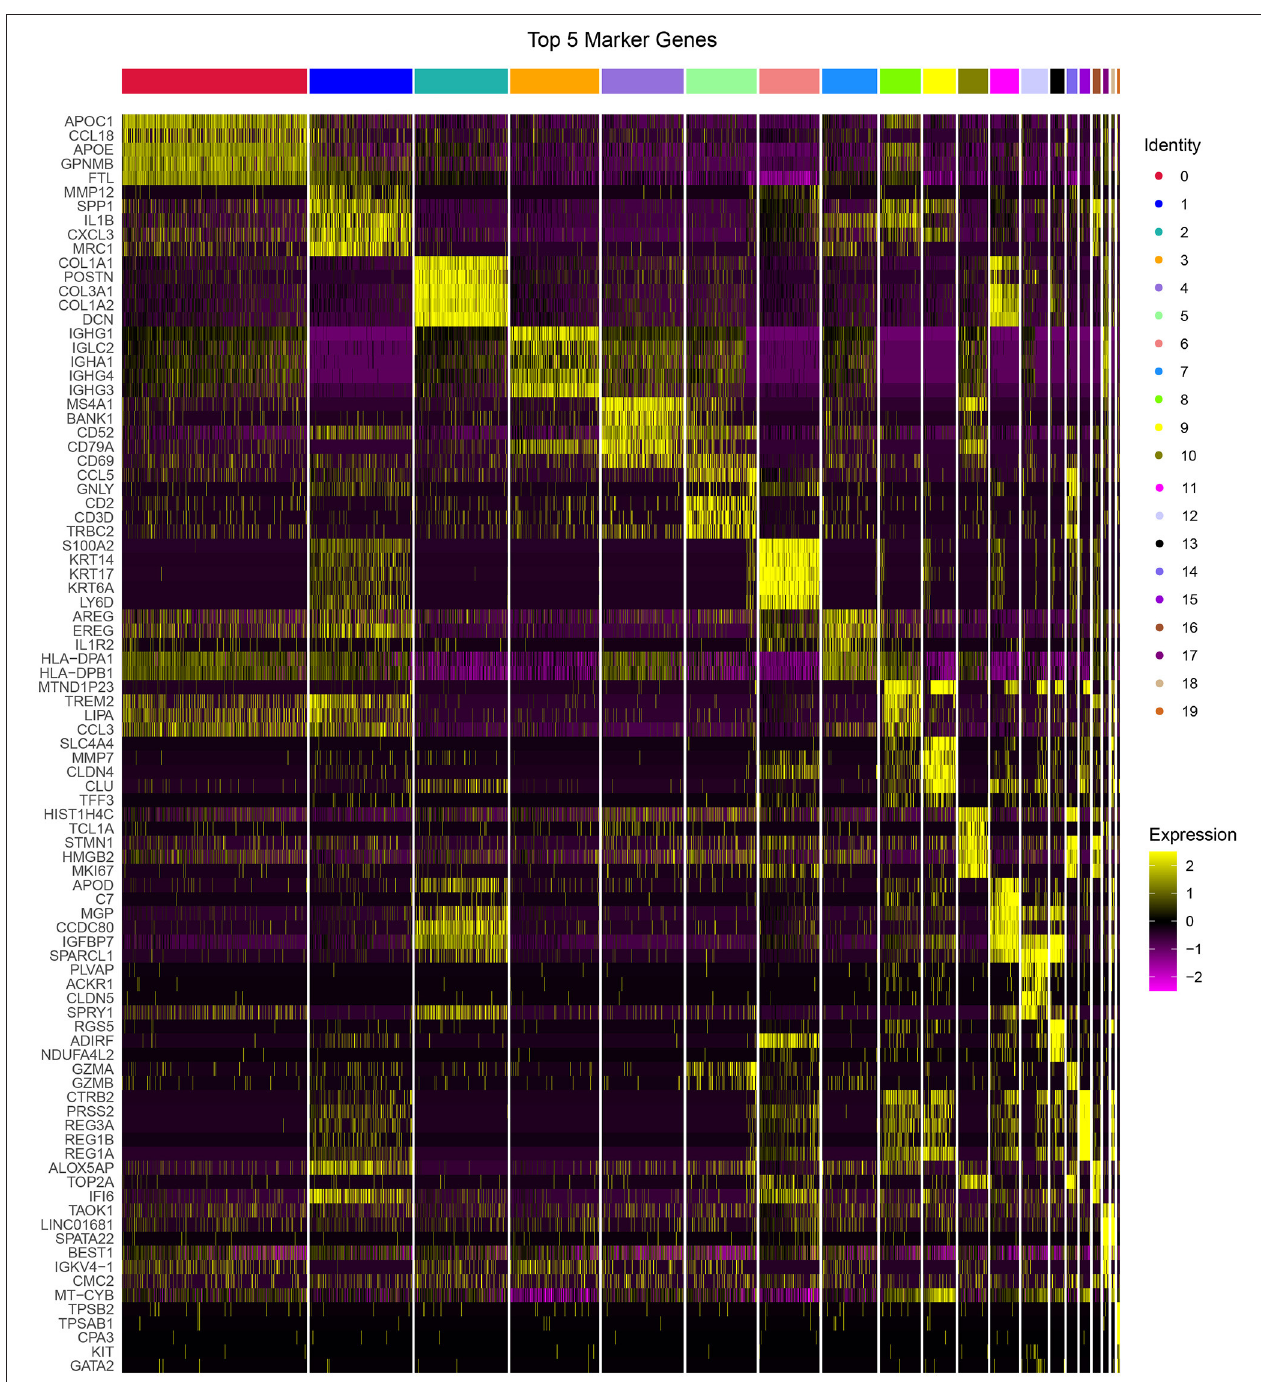
FIGURE 2 | The top 5 markers of 20 subgroups. Yellow represents relatively high expression and plum represents relatively low expression.